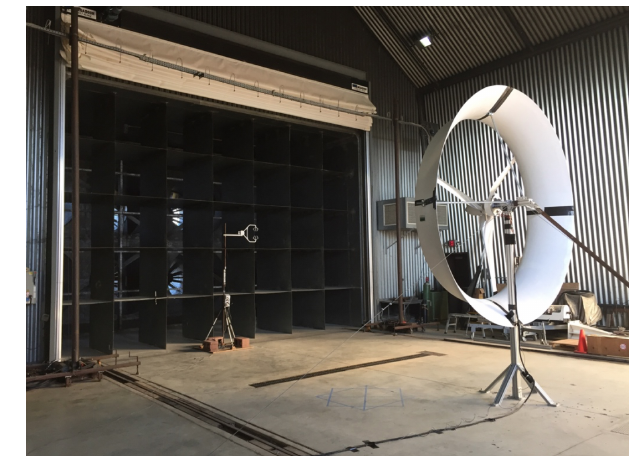
Figure 12. Ducted rotor under test conditions.